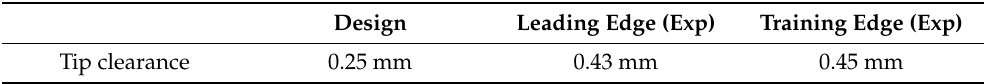
Table 8. The tip clearance of the experimental impeller.